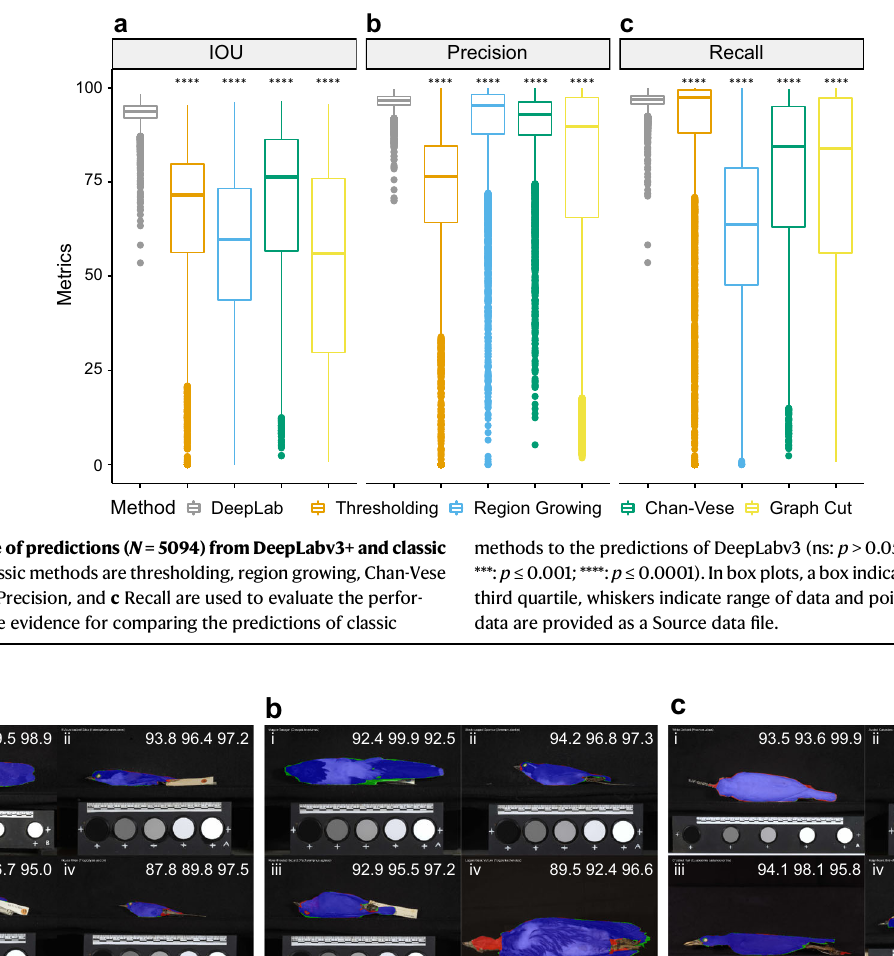
image. Blue is correctly predicted by the model (True positive); red is the non- plumageareathathasbeenclassi fi edasplumageareabythemodel(Falsepositive); green is the plumage area that has been classi fi ed as non-plumage area (False negative).